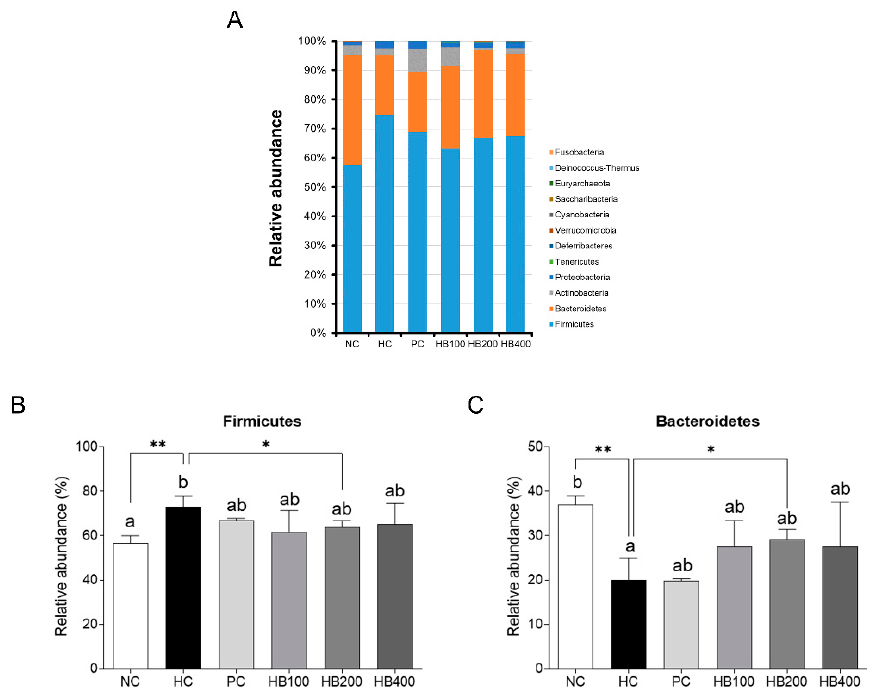
Figure 5. Fecal microbial relative abundance of phyla. ( A ) Bar plot represent the relative bacterial phylum abundance. Colors are used to distinguish each taxon. From the bottom, Firmicutes , Bacteroidetes , Actinobacteria , Proteobacteria , Tenericutes , Deferribacteres , Verrucomicrobia , Cyanobacteria , Saccharibacteria , Euryarchaeota , Deinococcus-Thermus , and Fusobacteria are shown. All data are mean ± SD. Significant differences among six groups are expressed as different letters based on one-way ANOVA ( p < 0.05), followed by Duncan’s multiple range tests. * p < 0.05, ** p < 0.01 versus HC group. The group means were compared by Student’s t -test.